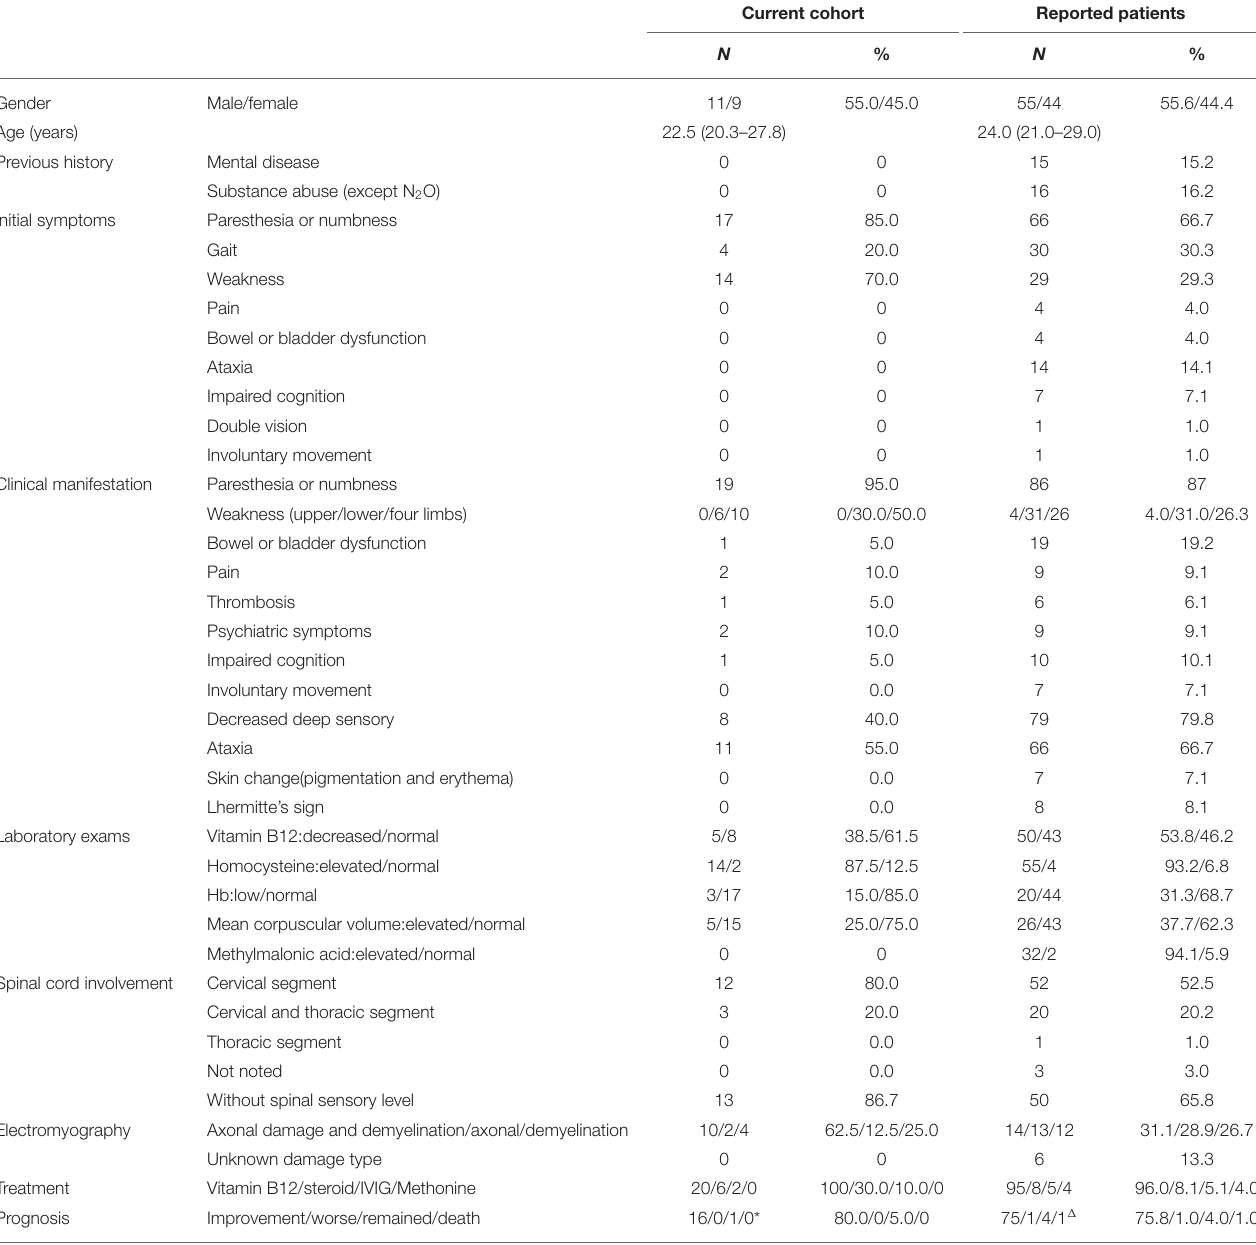
IVIG, intravenous immunoglobulin;/:data which were not collected; * three patients were lost; 1 seven patients were lost,11 patients’ prognosis were not mentioned. Age was expressed as median (Q1–Q3). Patients were treated with IVIG because most of them did not admit to N 2 O abuse at the beginning of treatment. Patients were treated with steroids, either to alleviate edema of the spinal cord or because they did not admit to N 2 O